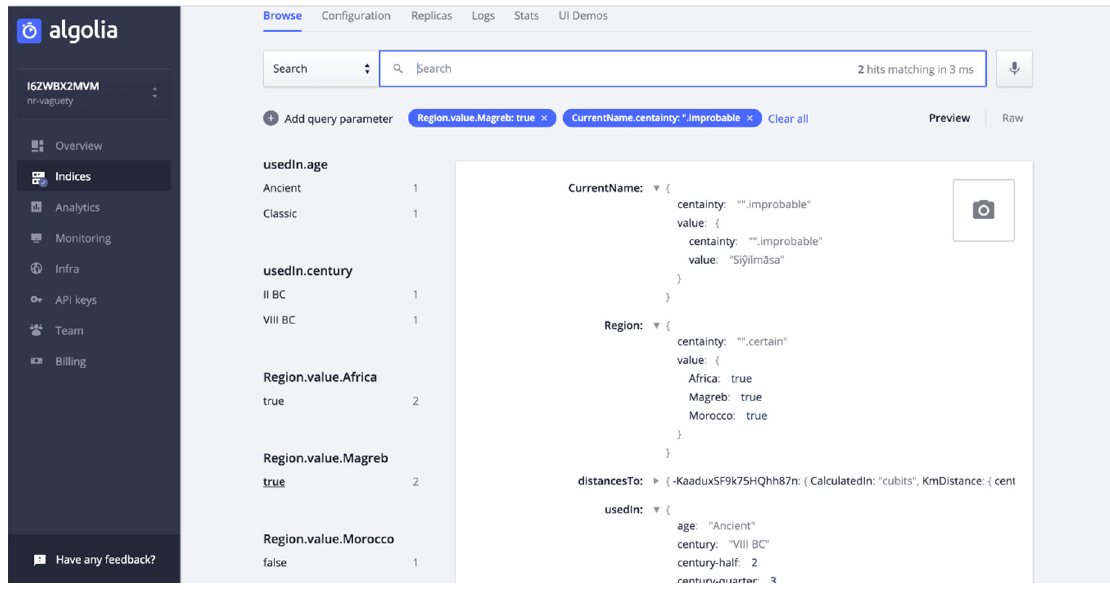
Figure 9 . Results for query A .